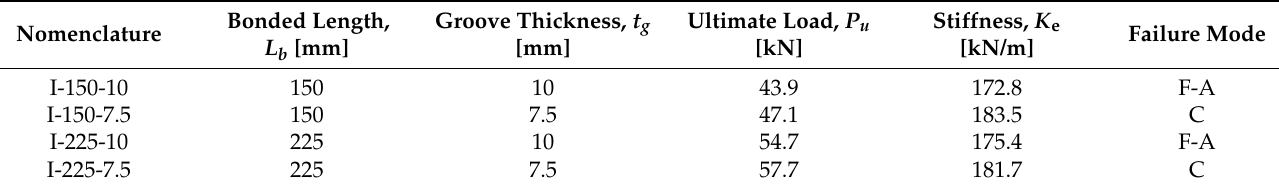
Table 1. Experimental results of the instantaneous pull ‐ out tests.